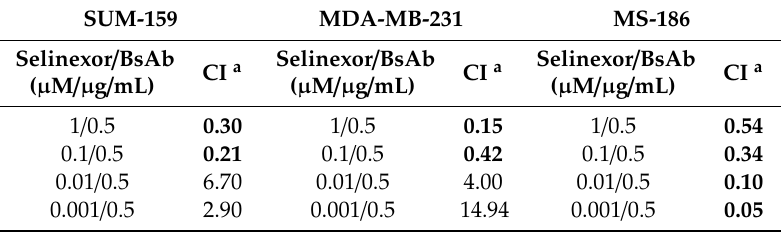
TNBC cell lines.